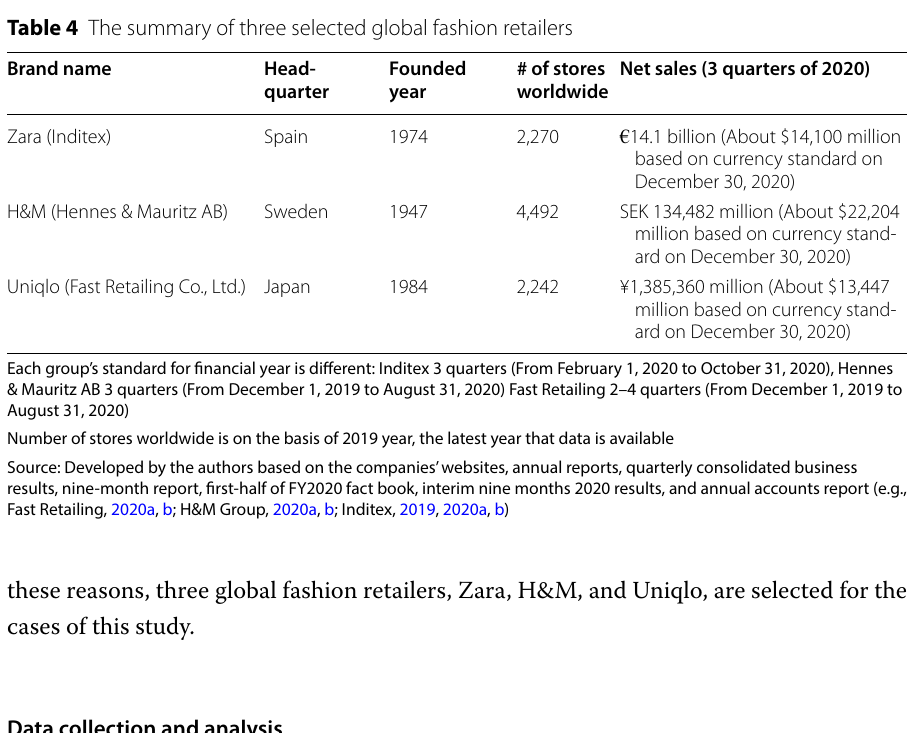
Table 4 The summary of three selected global fashion retailers